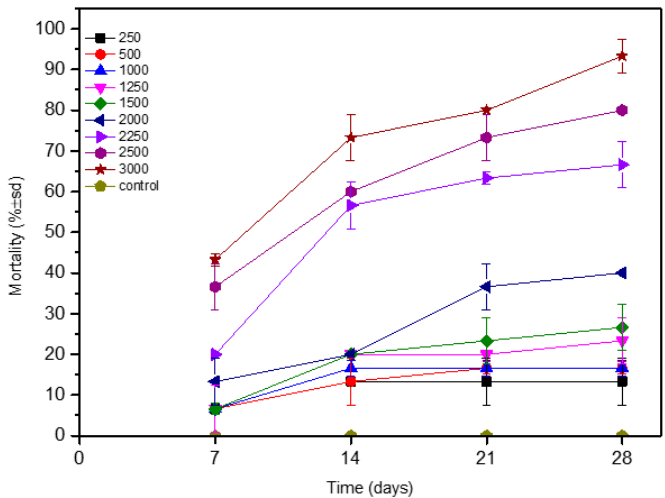
Figure 1. Mean mortality (% ± SD) of T. molitor adults sprayed with six concentrations of cyantraniliprole after 28 days.